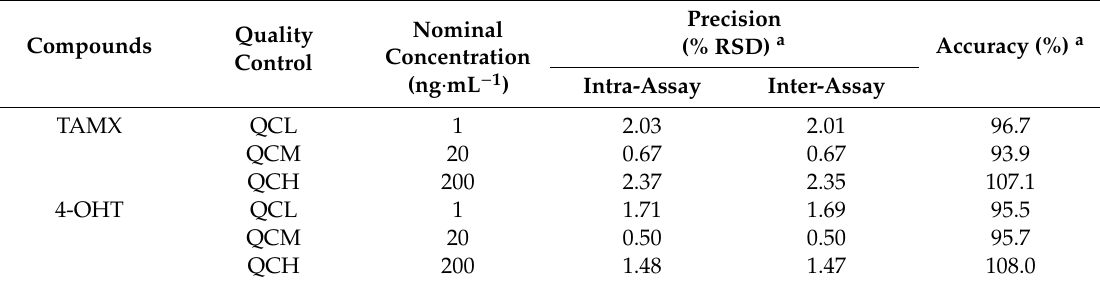
Table 2. Intra-day and inter-day precision and accuracy of TAMX and 4-OHT.